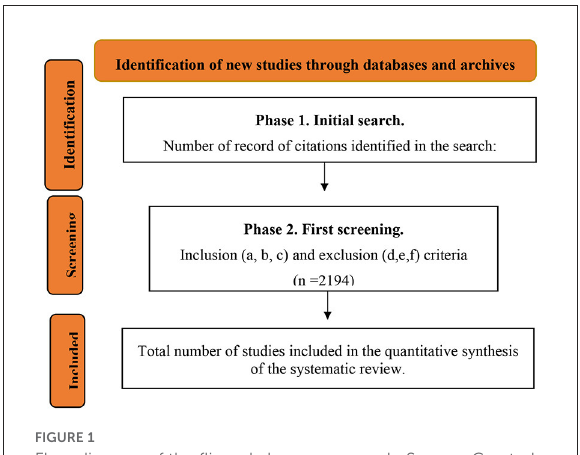
FIGURE1 Flow diagram of the flipped classroom search. Source: Created by authors from Web of